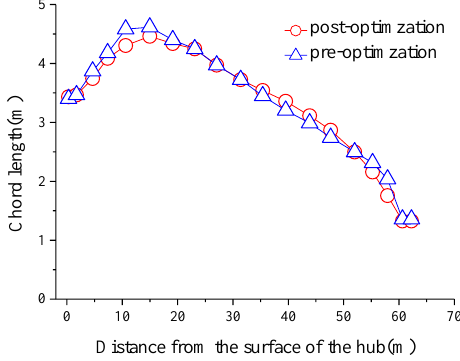
Figure 18. Distribution of the chord length at mid-low wind speed before and after optimization.